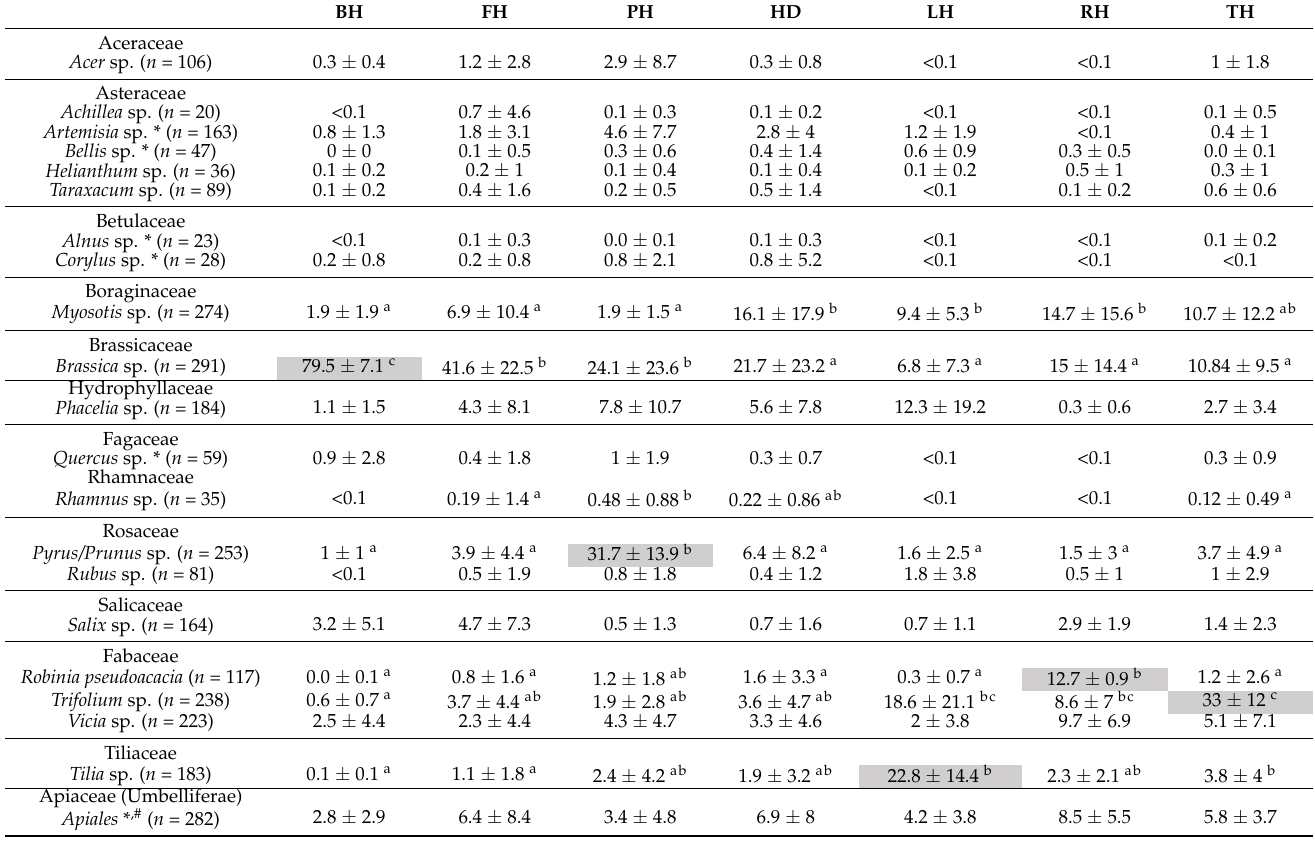
Table 3. Relative pollen frequency of Czech